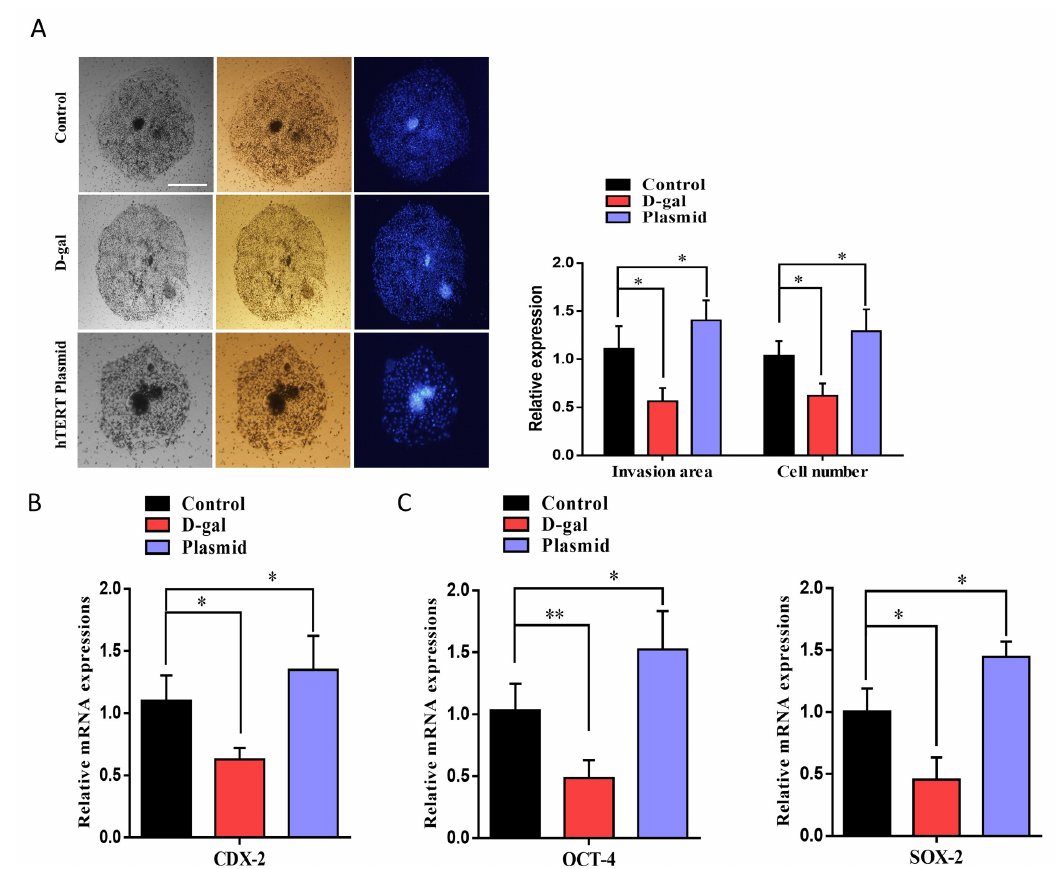
Figure 5. Constitutive expression of TERT enhances embryo implantation potential and inner cell mass (ICM)-related genes. ( A ) The effects of D-galactose and TERT on blastocyst implantation potential were determined via invasion assay. Bright-field image showing the area of invasion and DAPI for migrant cells in day-8 blastocysts. Image J software (National Institute of Health, Bethesda, MD, USA) was used to quantify the signal intensity of immunofluorescent images. The invaded area and cellular migration were significantly lower in the D-galactose-treated group than the control and TERT- treated groups and Bar = 100 µ m.( B ) CDX-2 gene related to embryo implantation and invasion of maternal uterine tissue was analyzed via RT-qPCR. ( C ) Inner Cell Mass (ICM) related genes like OCT-4 and SOX-2 were analyzed to check the embryo quality. The results showed that both the genes were significantly reduced with D-galactose treatment compared to control TERT plasmid injection. The experiments were repeated 3 times, and the data are shown here as the mean ± S.E.M. * = p < 0.05, and ** = p <